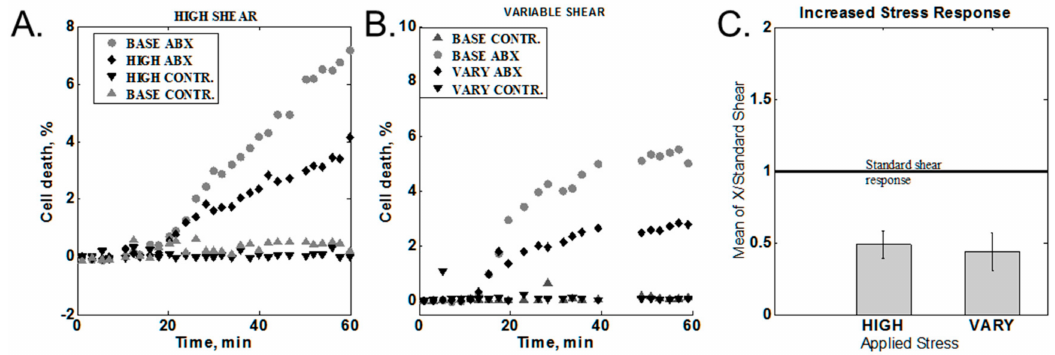
Figure 4. Effect of increased shear response. ( A ) Constant increased shear. BASE = standard shear stress; HIGH = high shear stress (10 × ), ABX = media with antibiotic, CONTR. = media without antibiotic ( B ) Variable between high and standard shear (1 × <-> 10 × ). VARY = variable shear response. ( C ) Summary of all high-shear